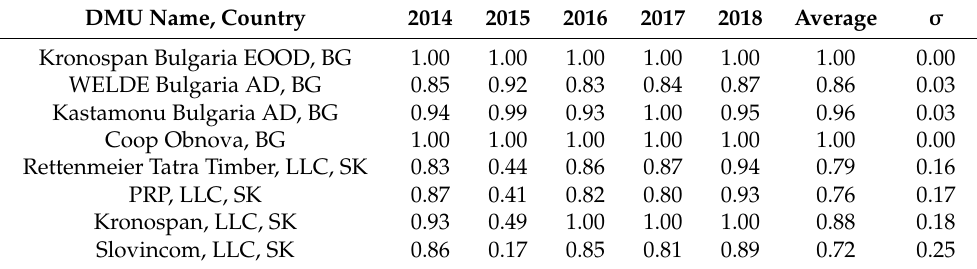
Table 2. CCR scores for DEA with inputs labour costs and materials costs for each enterprise. DMU Name,